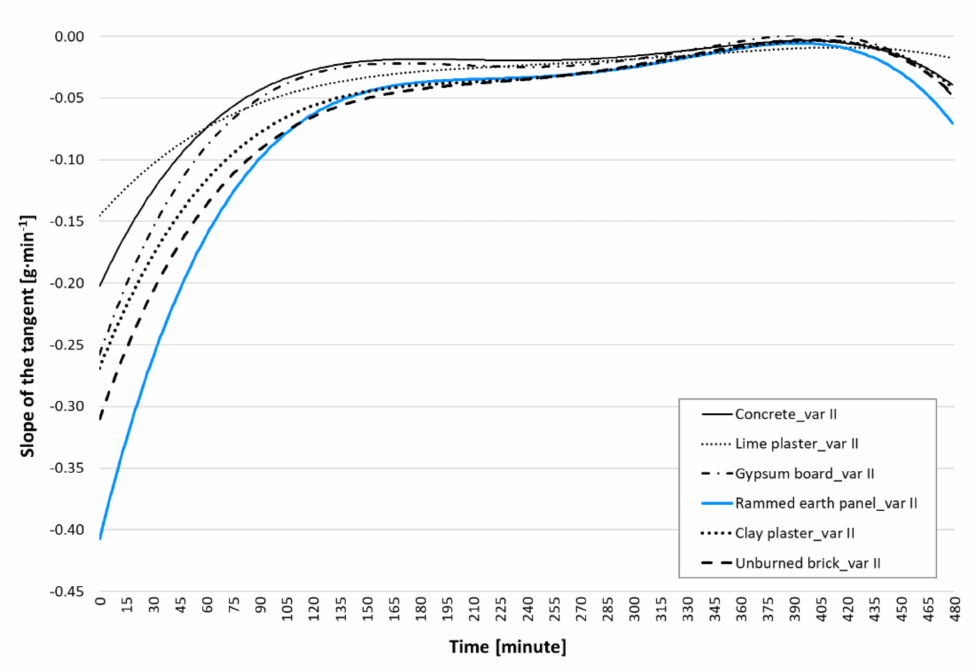
Figure 10. Slope of the dynamic adsorption